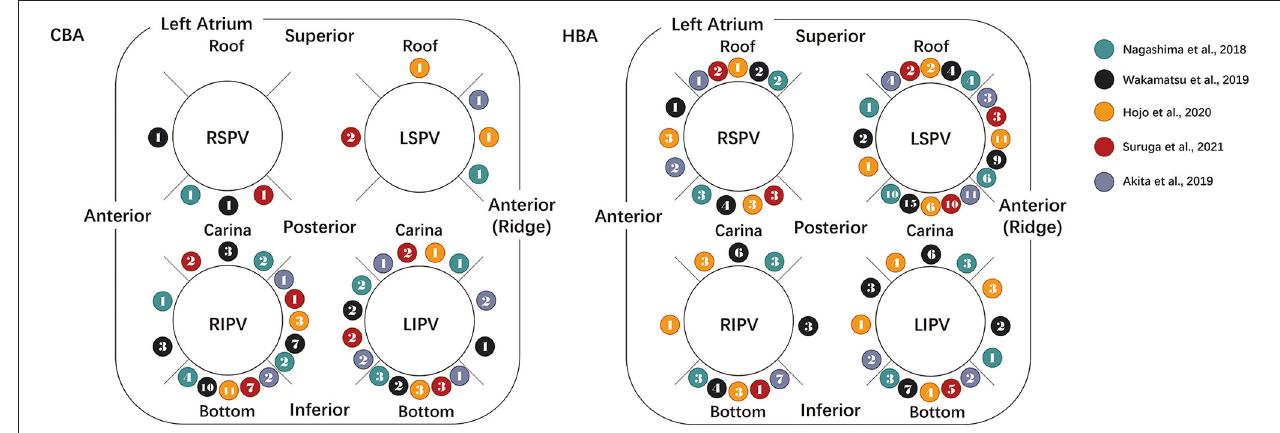
FIGURE 4 | Diagram showing the distributions of the touch-up ablation sites. The distribution of touch-up ablation sites following CBA (left) and HBA (right) is summarized in the above diagram. The rightmost legends show the included literature represented by spheres of different colors. The number in the balls indicates the touch-up ablation incidences and sites reported in the literature. CBA, cryoballoon ablation; HBA, hot balloon ablation; LIPV, left inferior pulmonary vein; LSPV, left superior pulmonary vein; RIPV, right inferior pulmonary vein; RSPV, right superior pulmonary